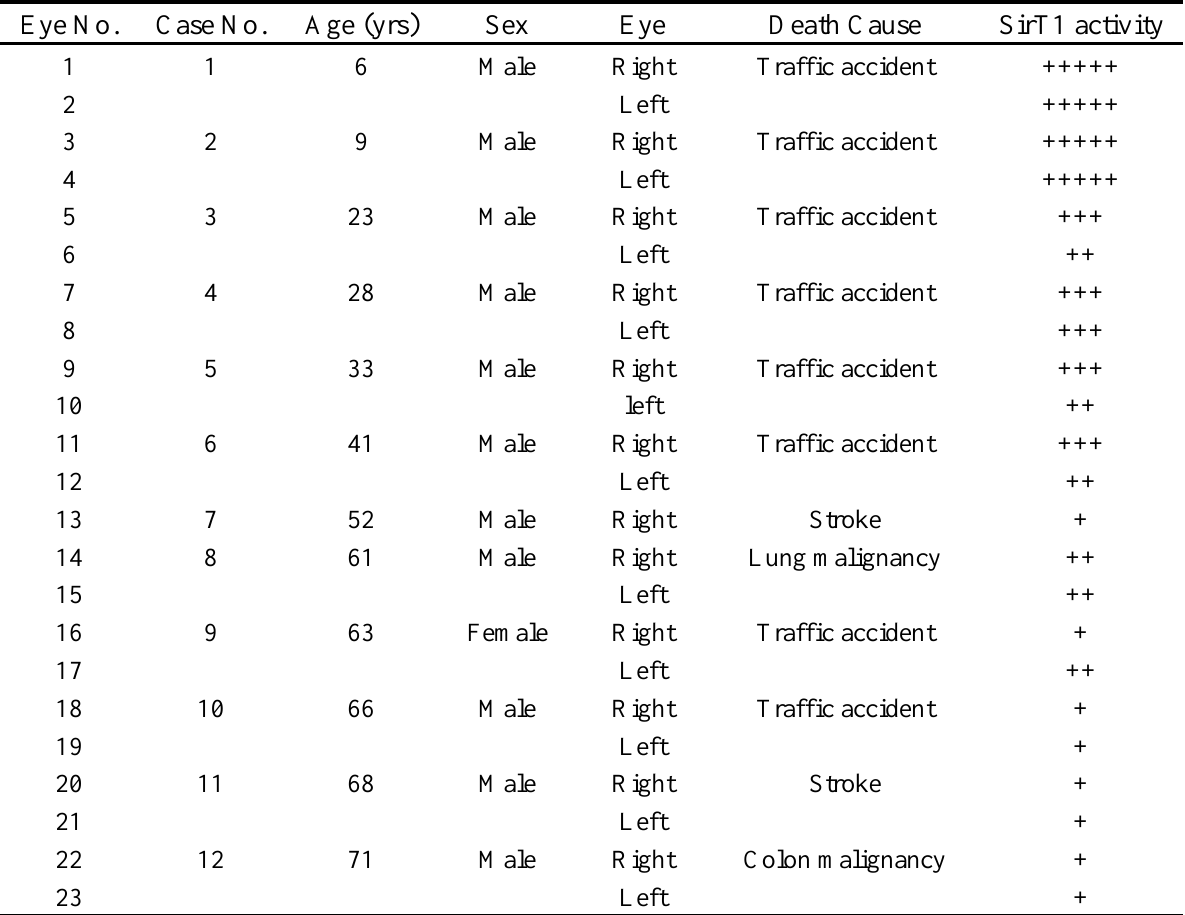
Table 2. Characteristics of patients for ocular retinal stem cell